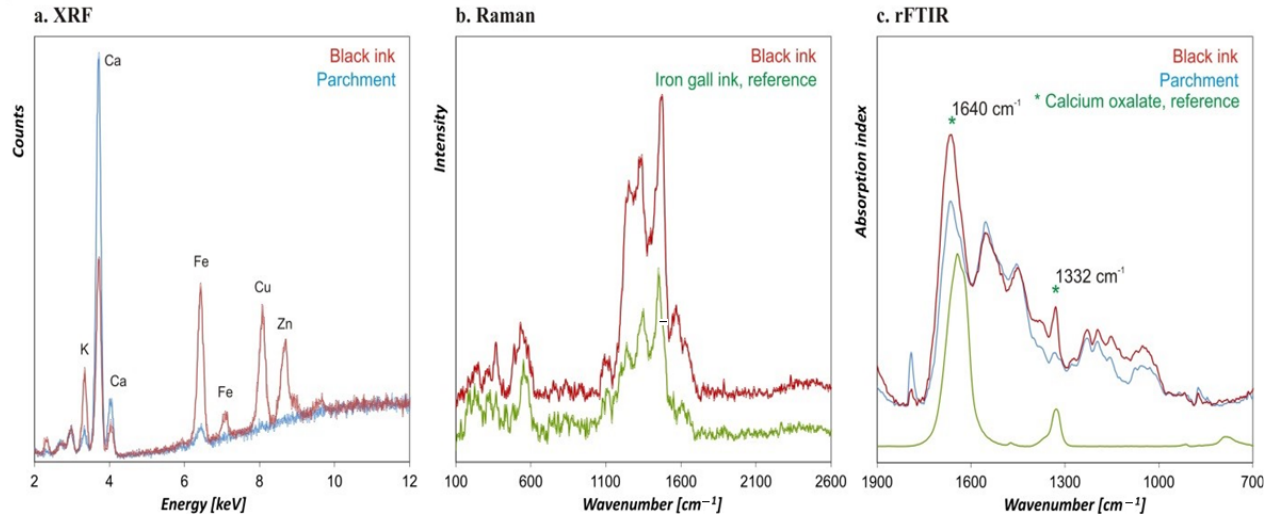
Figure 3. Analysis of black ink in the Kiev Folia performed with ( a ) XRF, showing its elemental composition with high counts in the quantity measure of iron (Fe) in comparison with the parchment (in blue), suggesting the presence of an iron ‐ based ink. ( b ) Raman spectrum confirming the presence of an iron gall ink (green reference spectrum), and ( c ) rFTIR revealing the presence of calcium oxalate (green reference spectrum).